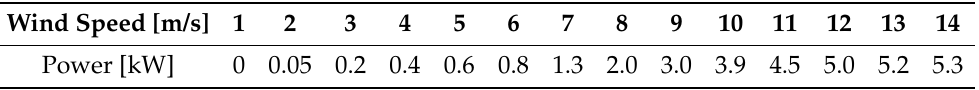
Table 2. Characteristic power output of an Aeolos-V 5 kW vertical small wind